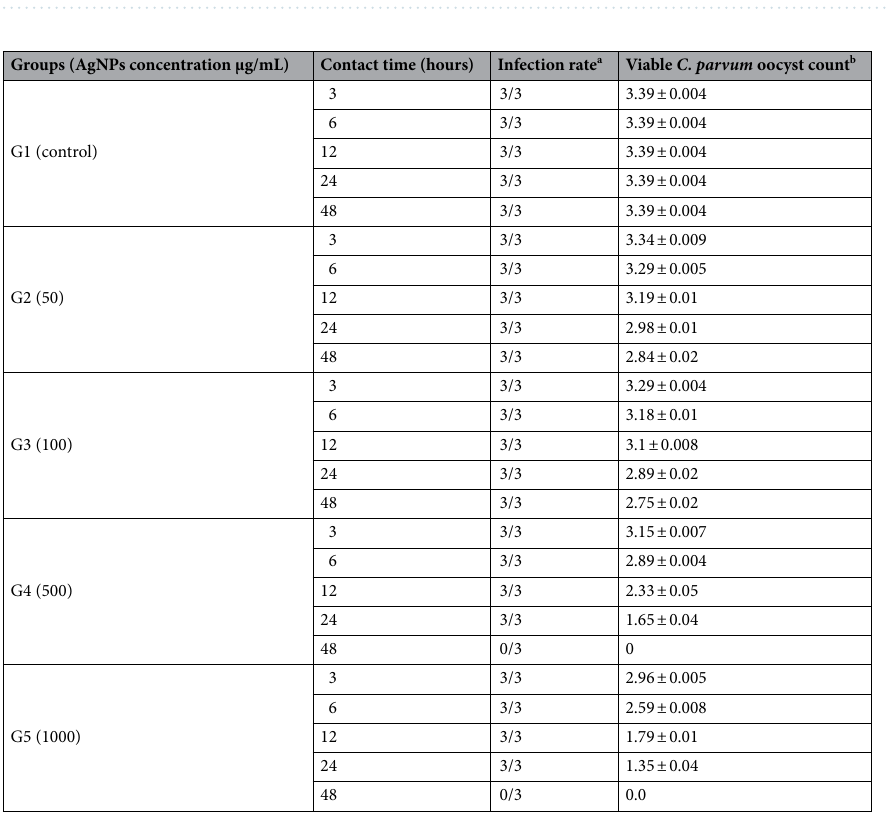
Table 2. Count and infection rate of C. parvum treated with different concentrations of AgNPs in laboratory mice. a No. of positive mice/no. of inoculated mice. b Each value represents the mean ± standard deviations of three counts of viable oocysts.